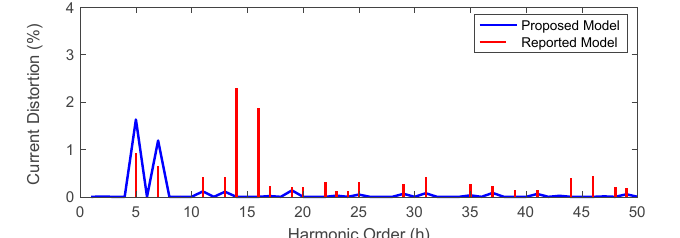
Figure 31. Comparison between developed and established MVDC converters’ total output current spectra.